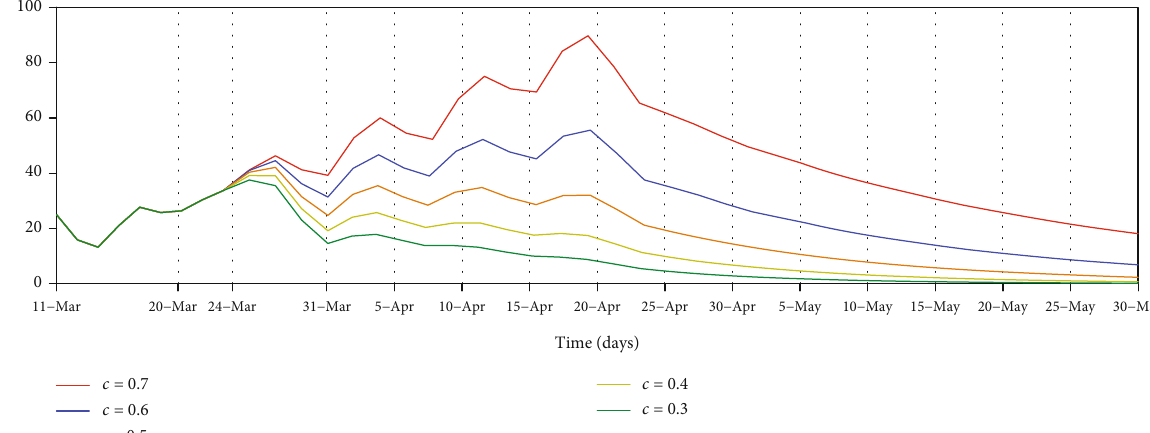
Figure 7: Estimated exposed population for di ff erent contact rate values in Sri Lanka.